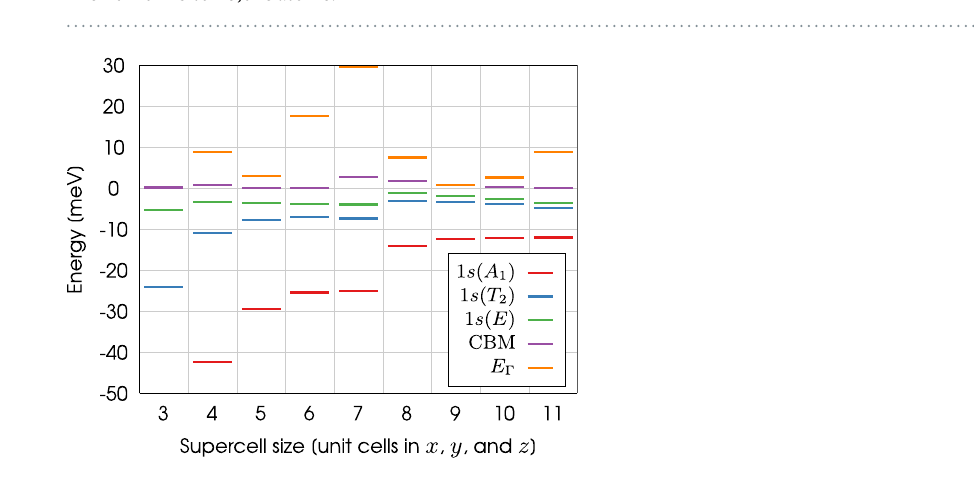
Figure 5. The energy levels of the s A 1 ( ) , s T 1 ( ) , and s E 1 ( ) states for supercells that range in size from 216 to 1 2 10,648 atoms. The energy of the CBM and the lowest conduction valley at Γ ( Γ E ) for bulk silicon are also shown for each supercell size. The conduction band minimum of the supercell containing 10,648 atoms has been set to energy